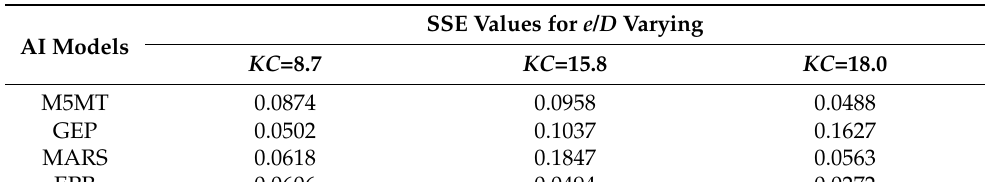
at various e/D ratios and L